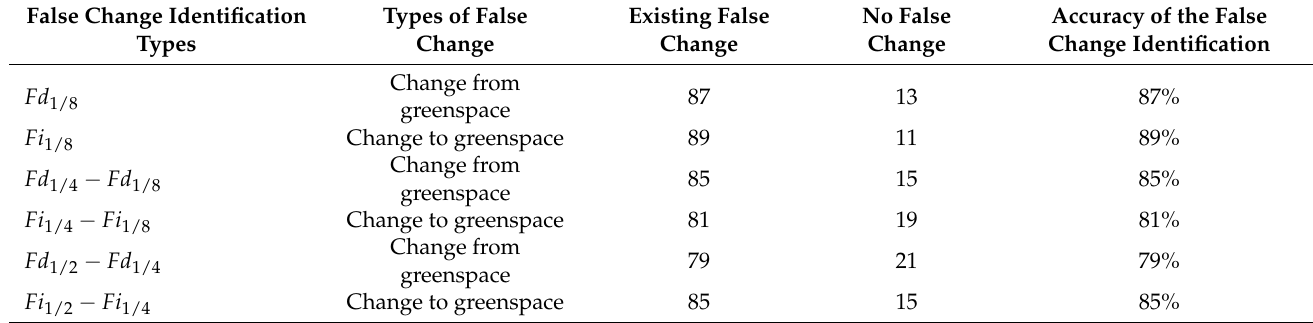
Table 1. Accuracy assessment of the false change identification.